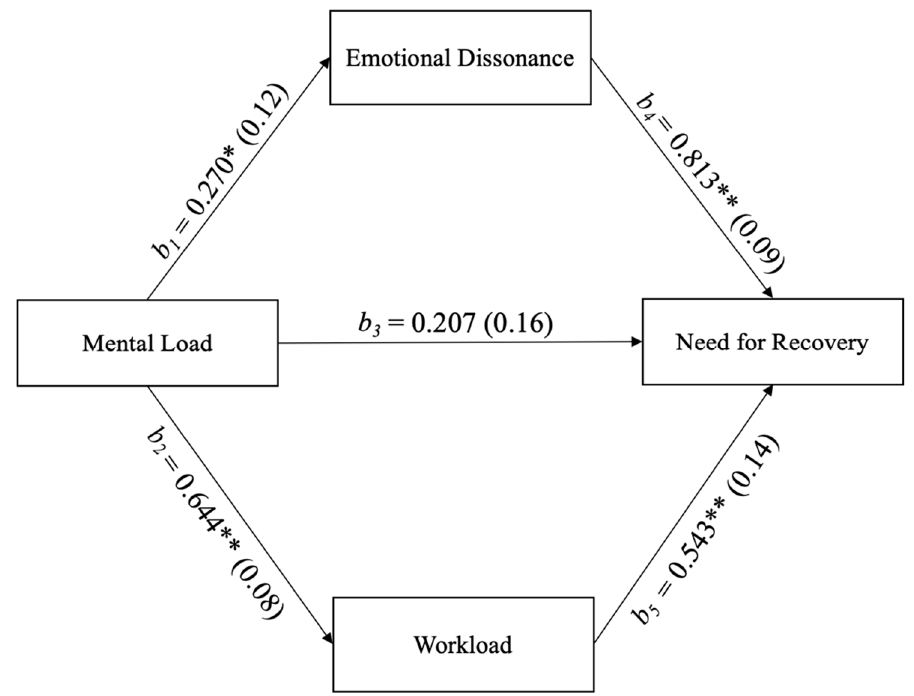
Figure 2. Parallel multiple mediation analysis of the mediators (Emotional Dissonance and Workload) in the relationship between Mental Load and Need for Recovery ( n = 157). Note: * p < 0.05, ** p <